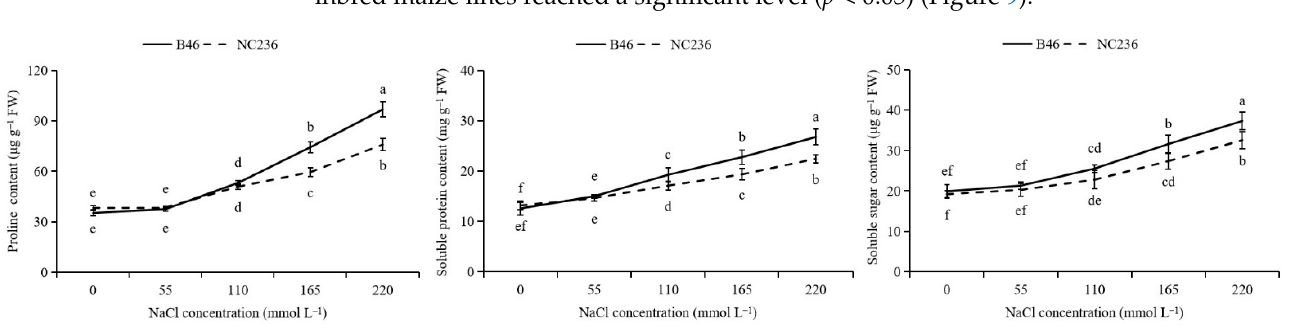
Table 1. Effects of salt stress on the contents of Na + , K + , and K + /Na + ratio in maize